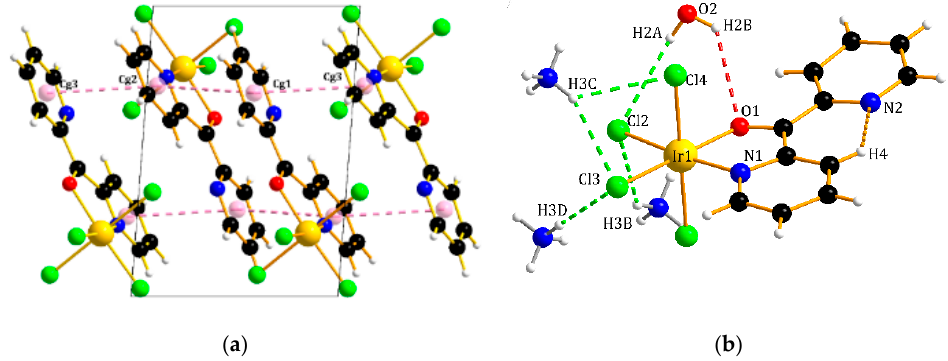
Figure 3. ( a ) The π ··· π interactions (aqua molecule and ammonium ion are omitted for clarity), ( b ) intra- and intermolecular hydrogen-bond interactions of 3 . Table 3. Hydrogen bonds for 1 and 3 [Å and deg.] and π ··· π interactions parameters.